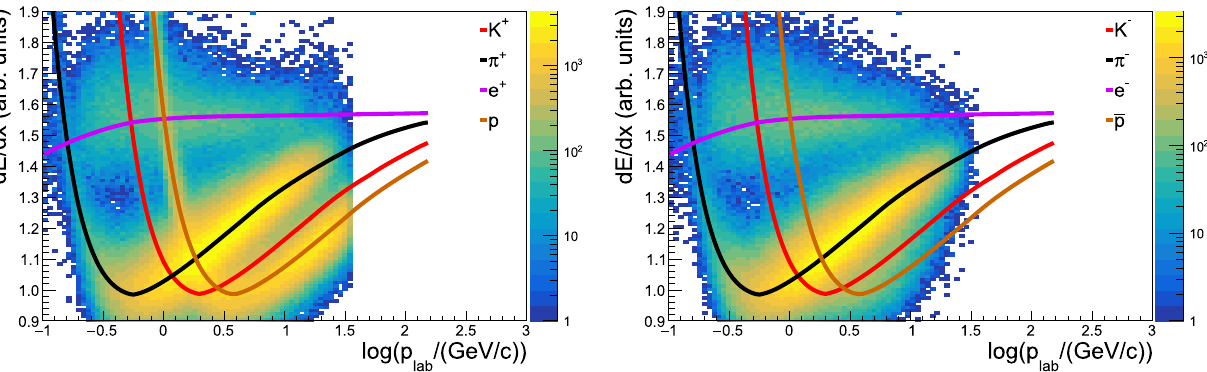
Fig. 2 The values of d E / d x versus log ( p lab /( GeV / c )) for positively (left) and negatively (right) charged particles after track cuts (i)–(vi) from Sect. 3.4. Data for inelastic p+p collisions at 40 GeV / c beam momentum. The empirical parametrizations of Bethe-Bloch curves are also